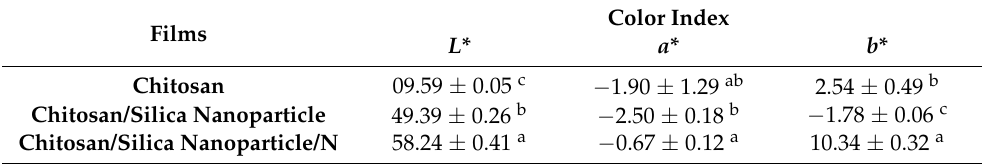
Table 3. Color index of coating